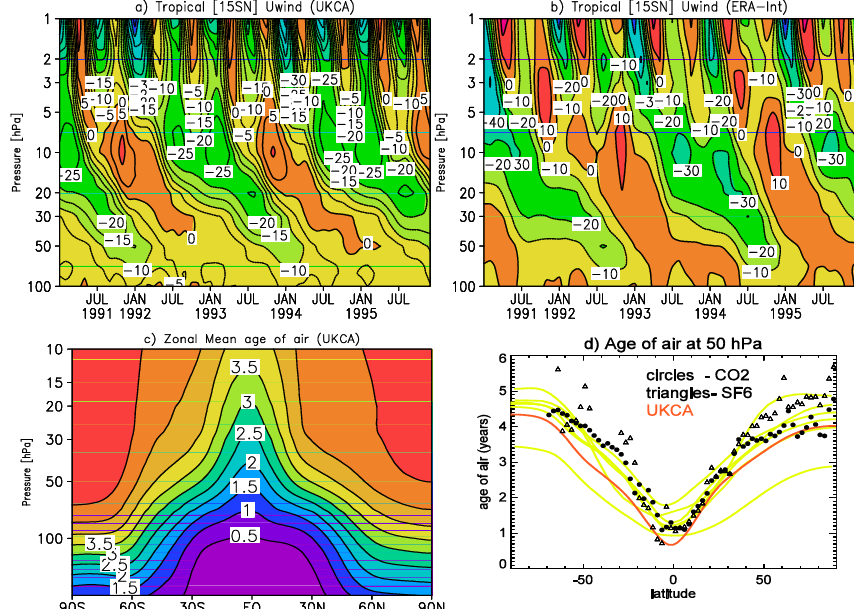
Figure 1. (a) Model-simulated tropical (15 ◦ S–15 ◦ N) mean monthly mean zonal wind (ms − 1 , QBO propagation). (b) Same as (a) but from ERA-interim reanalysis data (Dee et al., 2011). (c) Zonal mean age-of-air (years, mean 1991–2000), and (d) mean age-of-air (1991–2000) comparison at 50hPa. Triangles and filled circles show estimated age-of-air from CO 2 and SF 6 (Hall et al., 1999). Mean age-of-air from various CCMs which participated in SPARC Lifetime Assessment are shown with yellow lines and the one from this study is shown with the red line.